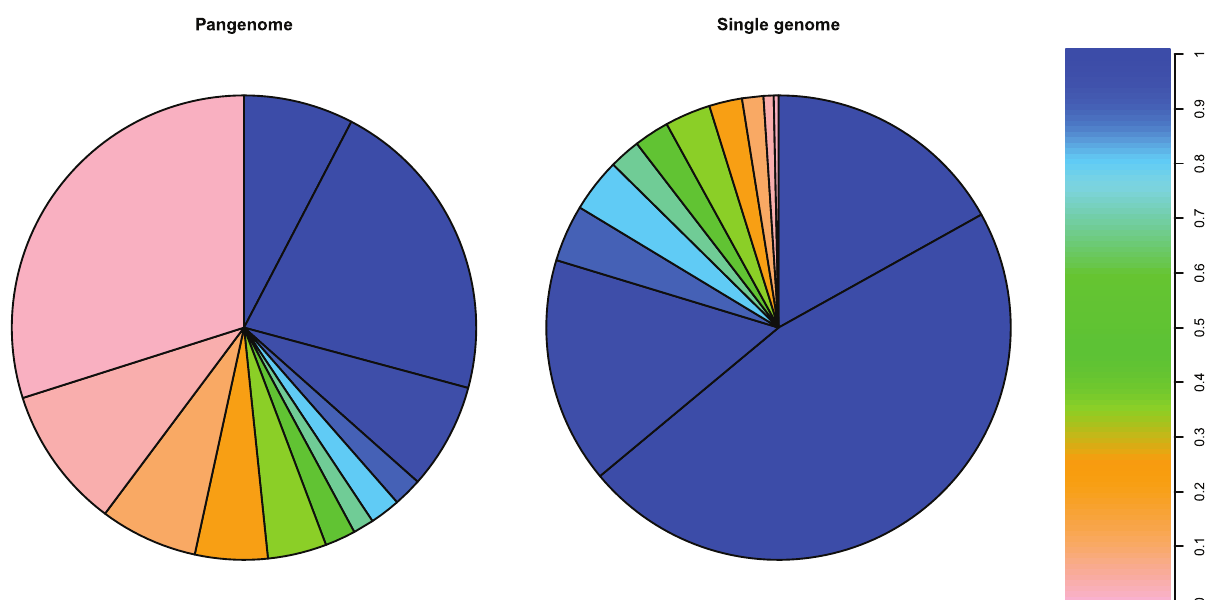
Figure 7. Binomial mixture model. The left pie chart visualizes the E. coli pangenome and the right pie chart a single E. coli genome described by a binomial mixture model. There are 12 sectors, and the colors indicate the selection probabilities as displayed on the right hand colorbar. The size of the each sector shows its relative contribution to the pangenome (left) or a single genome (right). The pangenome is dominated by domain sequences having either a very large (darker blue sectors) or very small selection probability (pink sectors). In a single genome the highly conserved domain sequences (darker blue) clearly